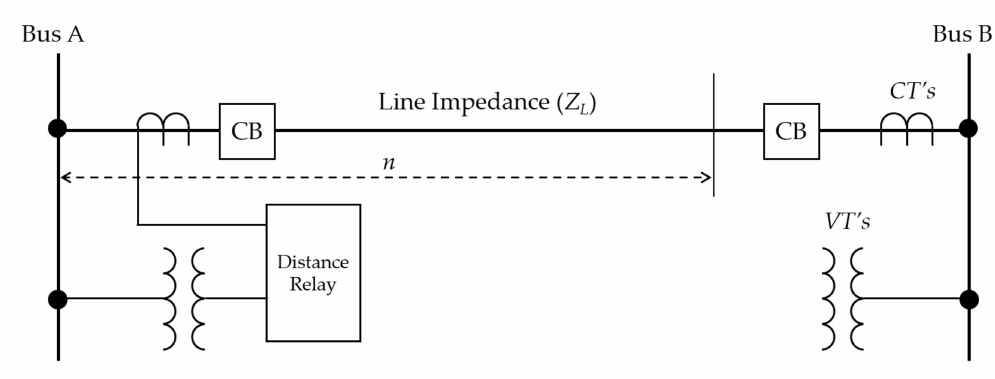
Figure 3. Distance relay between bus A and bus